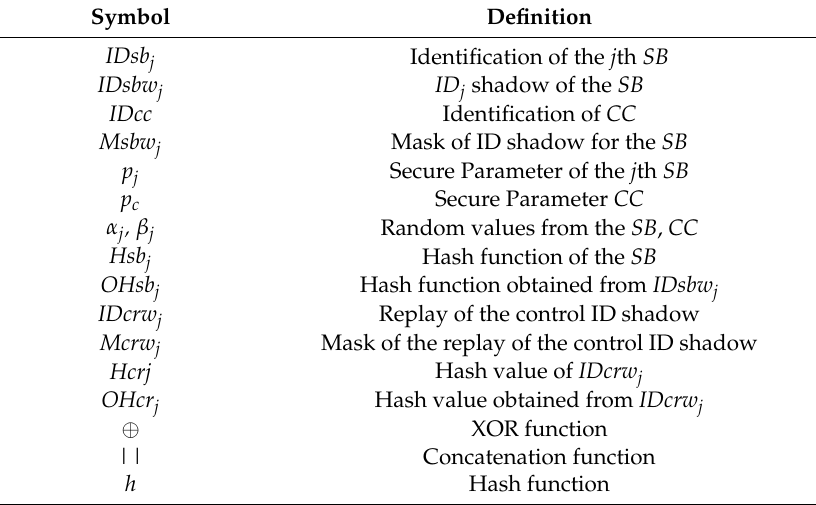
Table 1. The notation